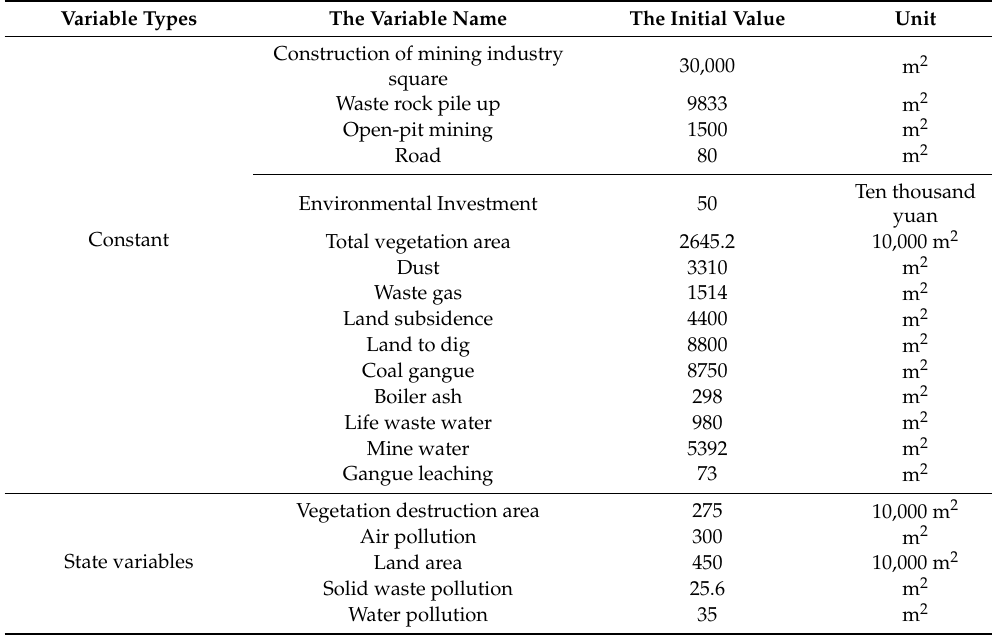
Table 1. The main parameters in the model.